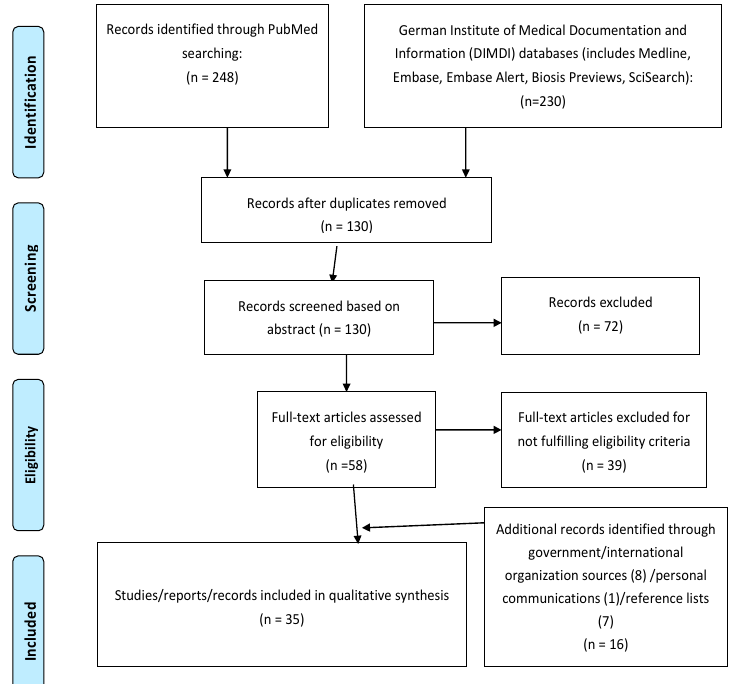
Figure 1. Flow chart of studies included in the review.